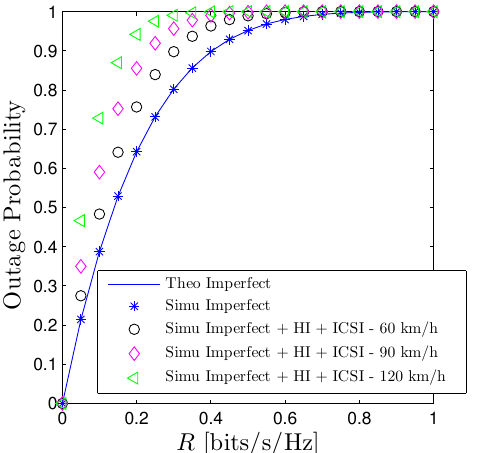
Figure 12. Outage probability vs. R under the impact of imperfect interference cancellation, hardware impairment (HI), and imperfect channel state information (ICSI). Solid lines are plotted by employing (16) while markers are Monte Carlo